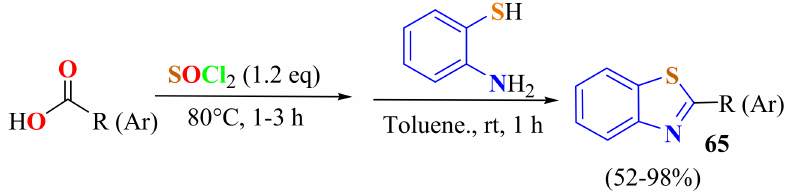
Scheme 48. In situ generation of aromatic acyl chlorides to be condensed with ATP. Wu et al. condensed the zinc salt of 4-amino-3-mercaptobenzoic acid with p -nitro